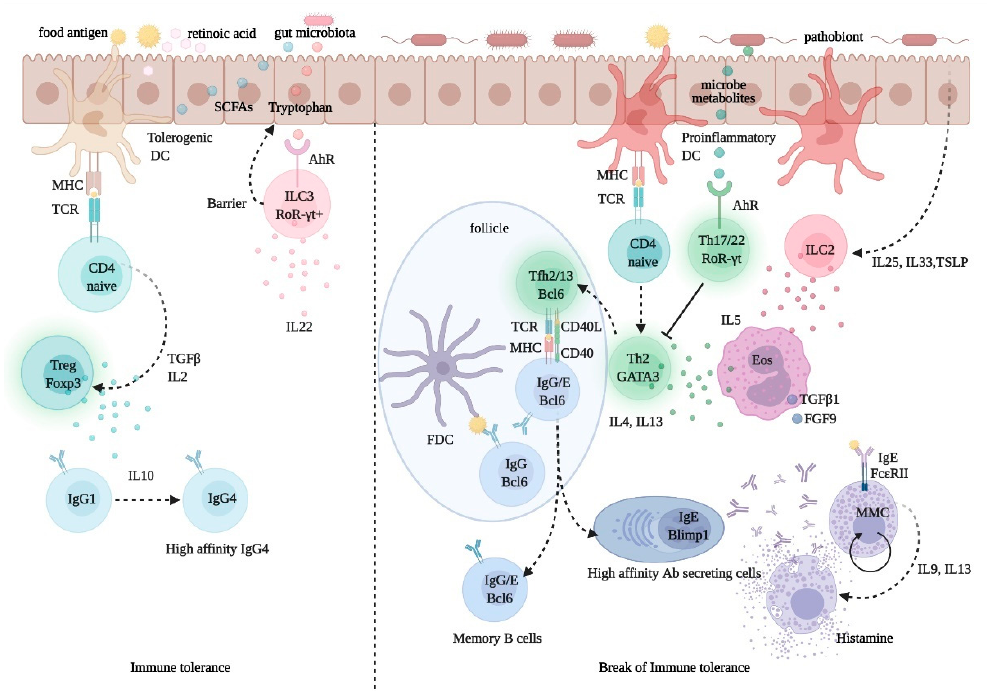
Figure 3. Regulation of immune tolerance in the gut mucosa. Upon processing of dietary fibers, bacterial metabolites, such as short chain fatty acids (SCFA) and retinoic acid (RA), direct the development and function of FoxP3 + Treg cells via the interaction with gut epithelial cells and tolerogenic dendritic cells (DCs) with naïve CD4 + T cells. The activation and expansion of Treg cells promote the production of the immune regulatory cytokine, IL ‐ 10, which foster IgG1 to IgG4 B ‐ cell class switching. Allergen ‐ specific IgG4 B cells produce high ‐ affinity antibodies for food allergens, preventing allergen interactions with mast cell ‐ bound IgE. Microbiota ‐ delivered factors, such as tryptophan ‐ indole catabolites, may directly activate ROR ‐γ t + type ‐ 3 innate lymphoid cells (ILC3), via the aryl ‐ hydrocarbon receptor (AhR), and induce the production of IL ‐ 22, a cytokine promoting gut epithelial regeneration and barrier integrity. Conversely, upon exposure to pathobionts, DCs and epithelial cells receive danger signals and release cytokines, such as IL ‐ 25, IL ‐ 33, and thymic stromal lymphopoietin (TSLP); these promote the activation and expansion of ILC2s, which express Th2 cytokines, such as IL4, IL ‐ 5, and IL13. While IL ‐ 5 promotes eosinophil activation and differentiation and the production of profibrotic factors, such as transforming growth factor (TGF) ‐β 1 and fibroblast growth factor (FGF) ‐ 9, IL ‐ 13 produced by Th2 cells and T follicular helper (Tfh) 13 cells, is critical for the expression of high ‐ affinity antigen ‐ specific IgE. IgE antibodies interact with Fc ε RI on mast cells and upon exposure to allergen triggers degranulation and release of histamine, which causes allergy and inflammation.